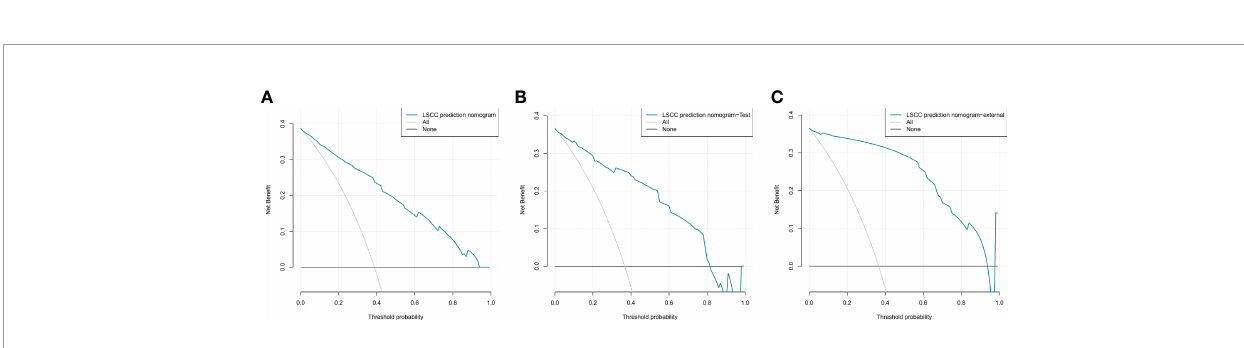
FIGURE 7 | Evaluation of validity and reliability of the model. ROC curves of the nomogram prediction model in the training cohort (A) , internal test cohort (B) , and, external test cohort (C) ; calibration curves of the nomogram prediction model for the training cohort (D) , internal test cohort (E) , and, external test cohort (F) .